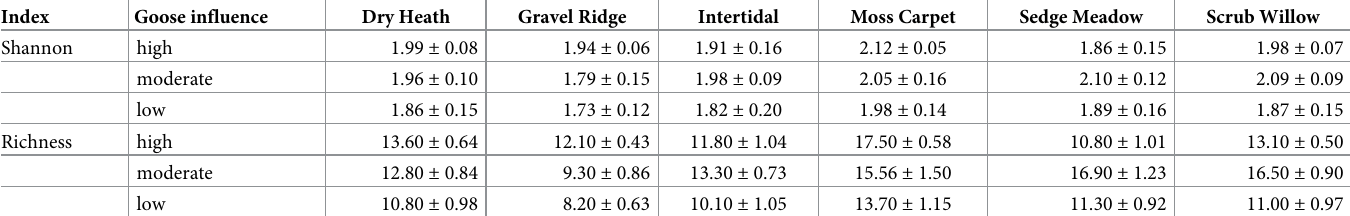
Table 2. Shannon diversity and taxa richness of invertebrates across traps and periods but among study sites representing a gradient of goose effects and habitat types (mean ±